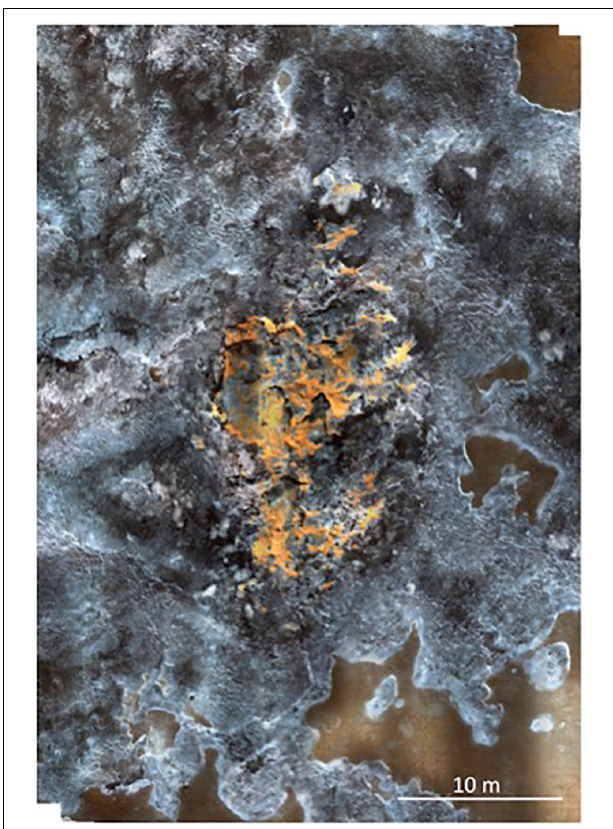
FIGURE 4 | Photomosaic of the Triton cold seep site. An ∼ 30 × 40 m area centered on the site of active fluid flow was selected for co-registered imaging and high resolution mapping surveys. This photomosaic is comprised of approximately 1500 color images. Within this image white microbial mats cover the gently upward sloping seafloor while within the center of the image, the steep-walled depression around the active seep exhibits higher rugosity and the microbial mats coating the walls and floor of that depression are a bright yellow–orange in color. Images were taken at an elevation of 3 m above the seafloor. Co-registered bathymetry is shown in Figure 5